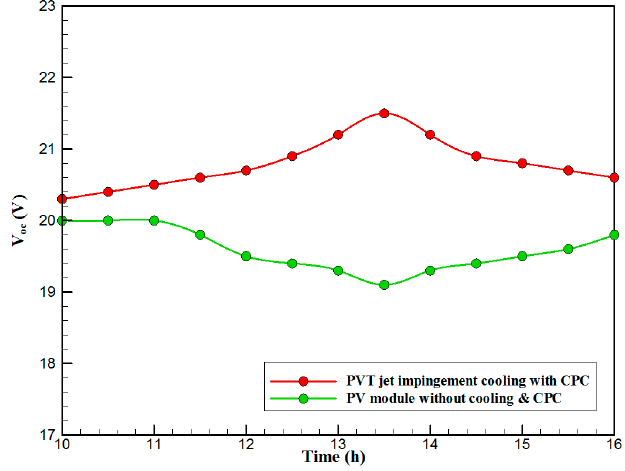
Figure 13. The hourly variation of open-circuit voltage for the PVT solar collector with CPC.